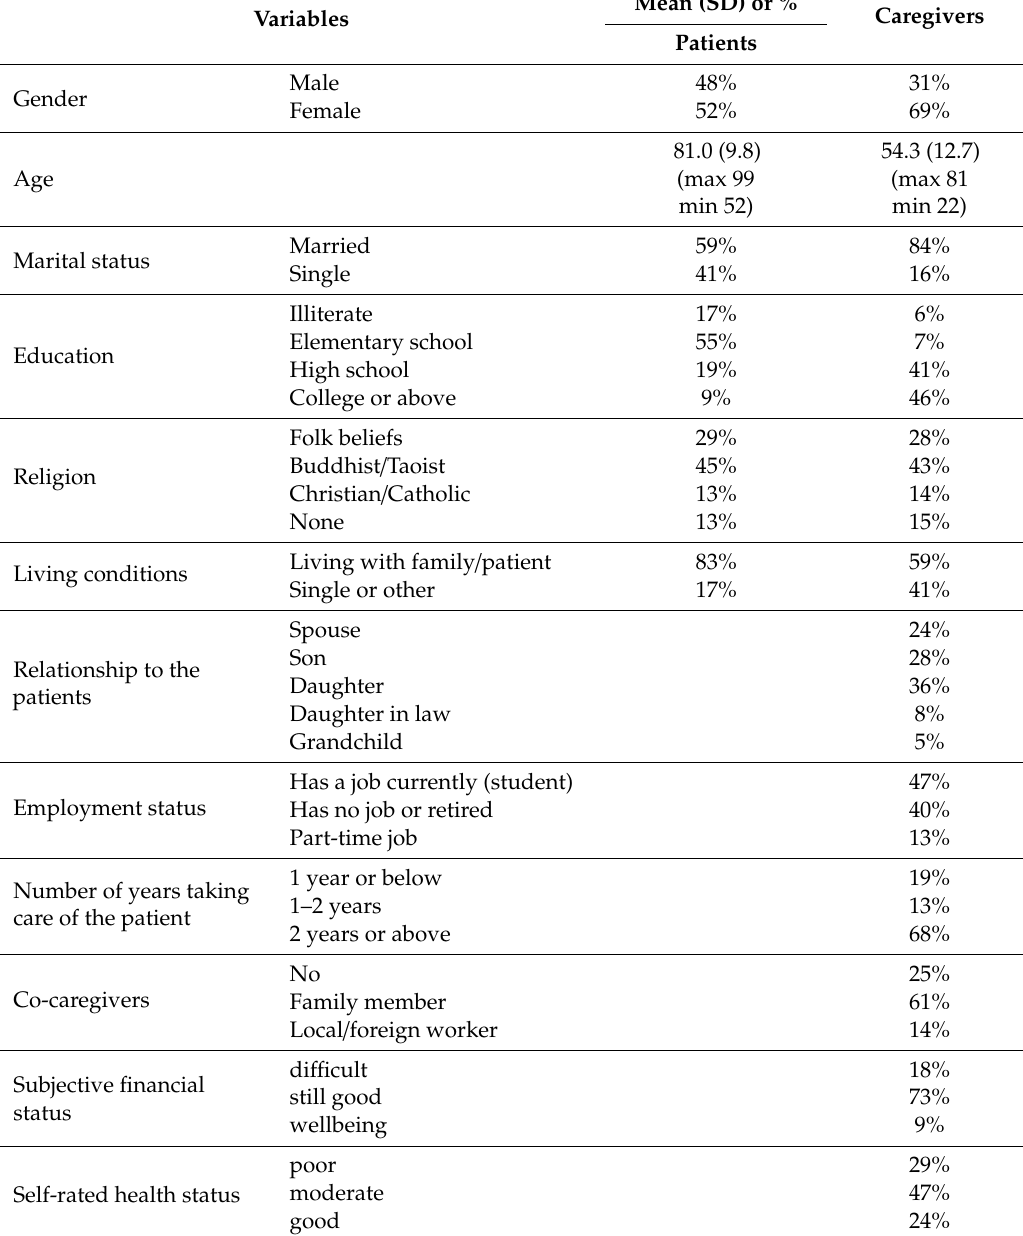
Table 1. Demographic data of the study